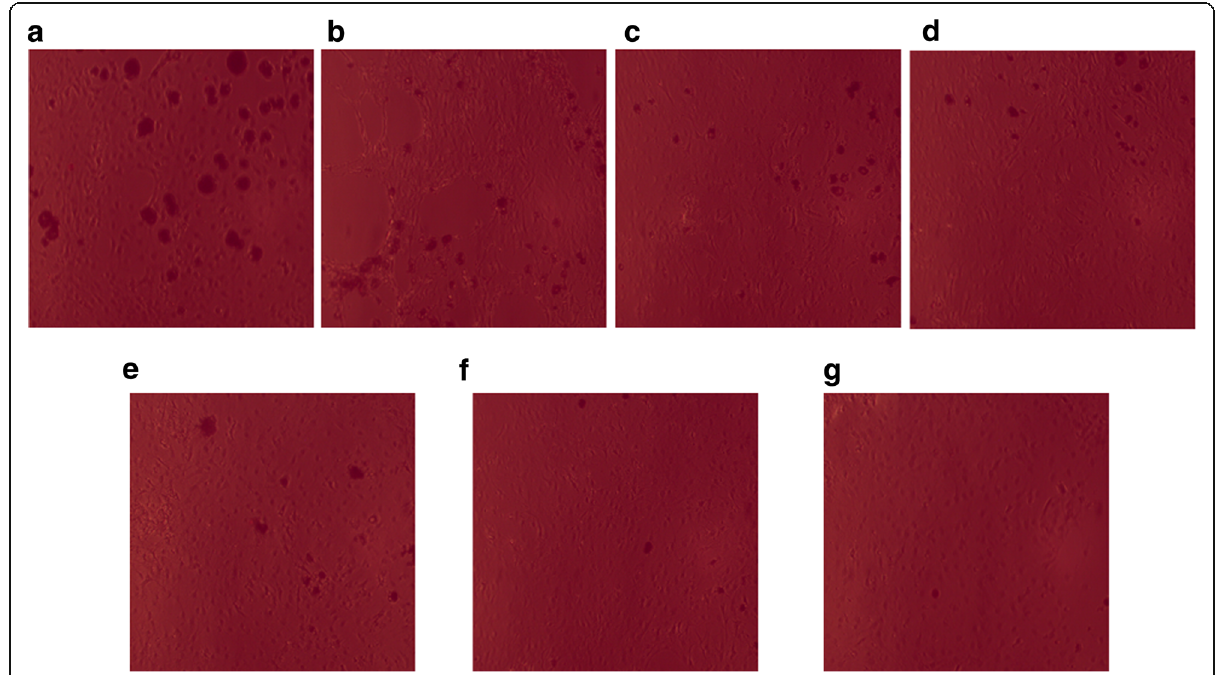
Fig. 6 The inhibition of 3 T3 cells differencing and lipid accumulation by various concentrations of crude microcystins determined by Oil Red O staining. a represent the photograph of 3 T3-L1 cells in control well ( 0 μ l/mL microcystins). b, c represents the photographs of lowest dose group of microcystins extract i.e. 5 μ l/mL . d, e, f and g represent the photograph of 3 T3-L1 cells line after treatment with crude microcystin in the